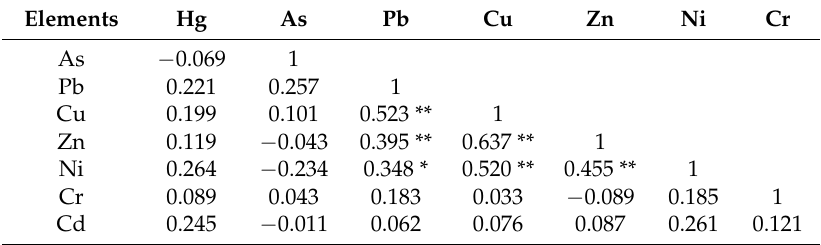
Table 5. Correlation coefficient among different metals in topsoils around industrial sites in Dongguan. Elements Hg As Pb Cu Zn